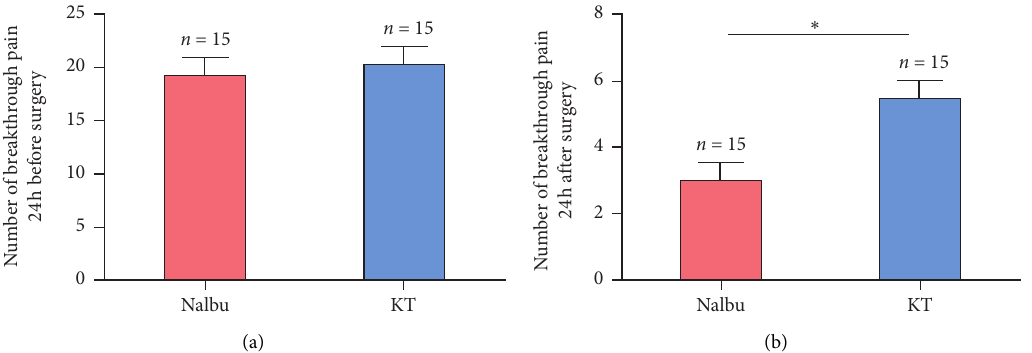
Figure 5: Number of breakthrough pain. (a) Number of breakthrough pain 24 h before surgery; (b) number of breakthrough pain 24h after surgery. Nalbu, nalbuphine; KT, ketorolac tromethamine; (h) hours. n � 15 for each group, ∗ P < 0 . 05.